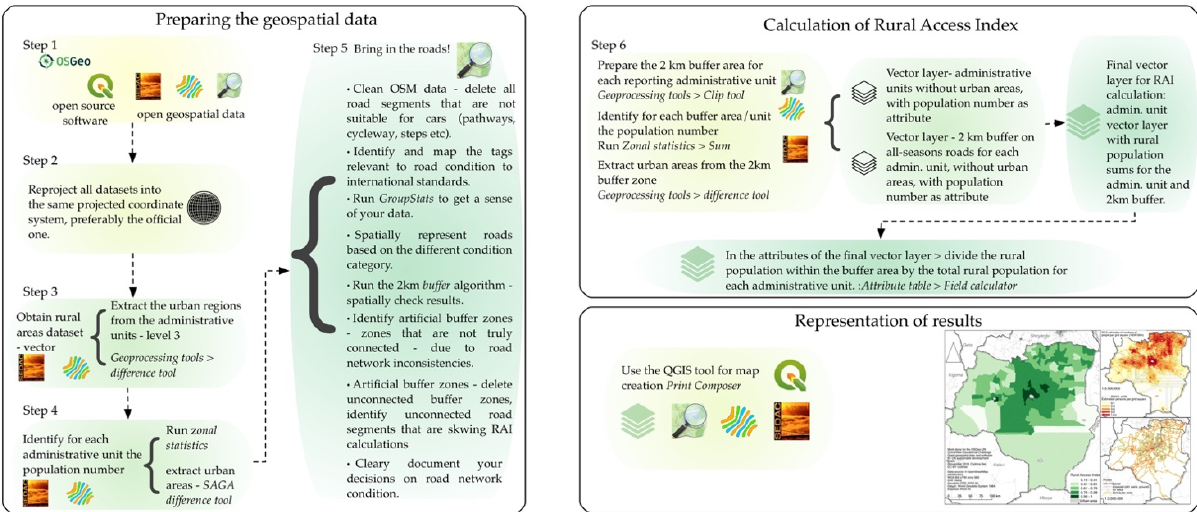
Figure 2. Workflow for calculating SDG